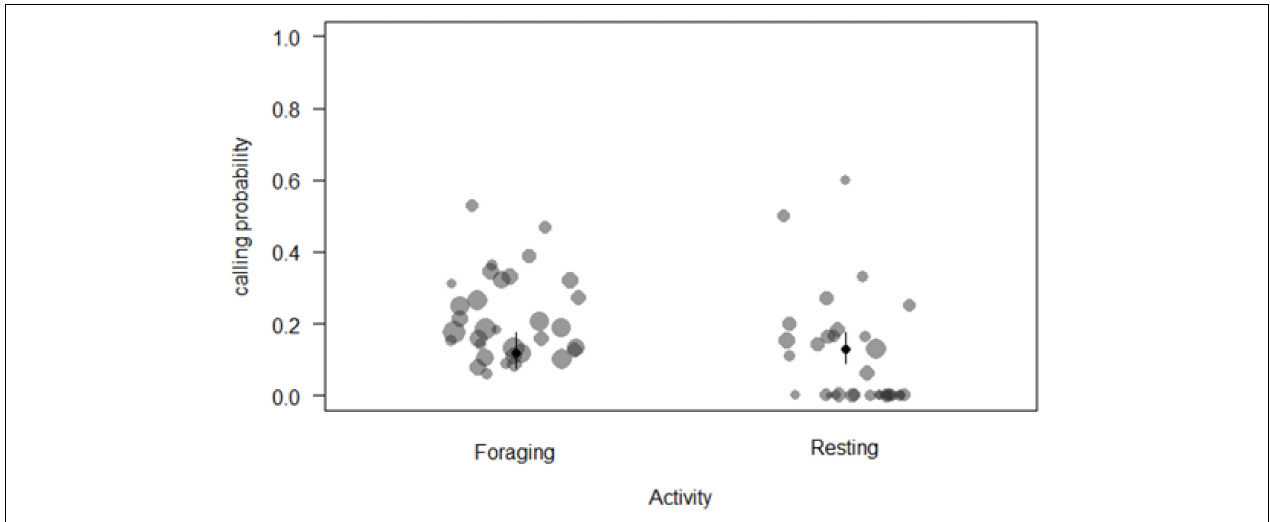
FIGURE 1 | Probability of call production by a focal animal during two main daily activities (circle sizes proportional to the number of samples per individual).